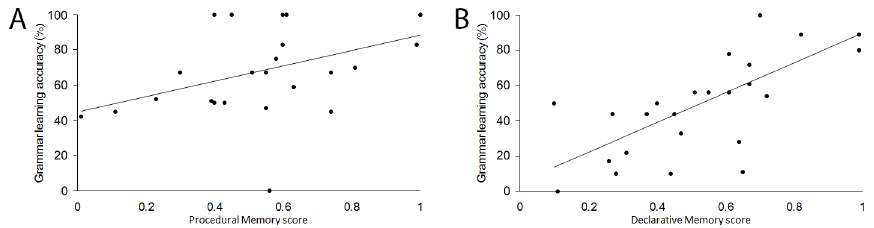
Fig 4. Scatterplots depicting correlations for no-feedback group between (A) procedural memory and simple grammar learning, and (B) declarative memory and complex grammar